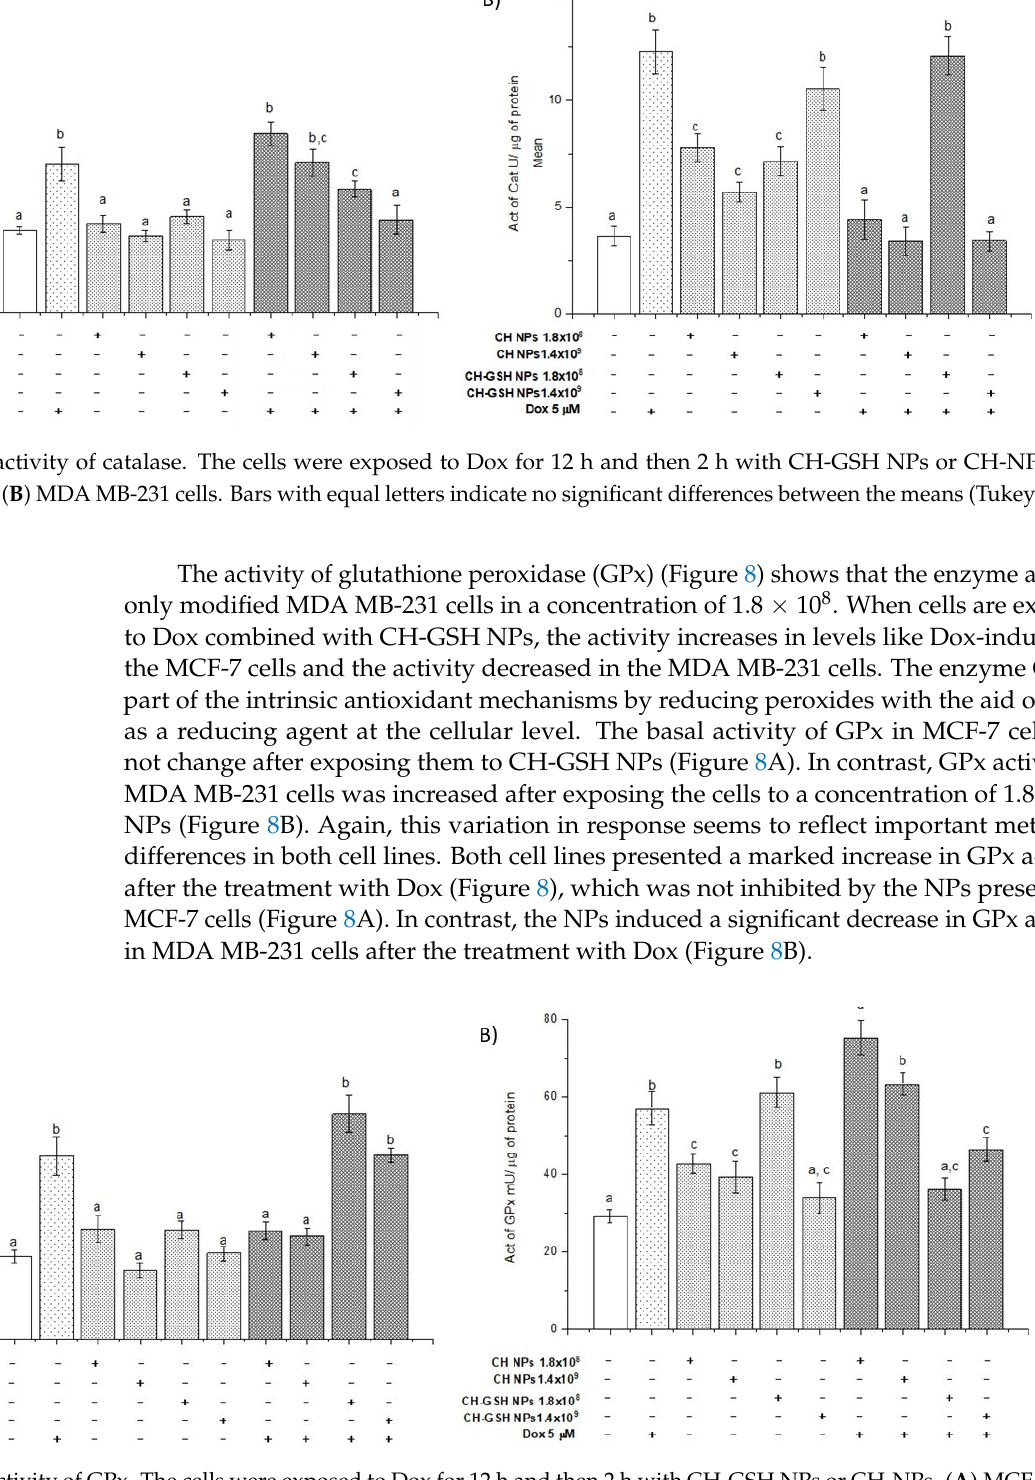
Figure 8. The activity of GPx. The cells were exposed to Dox for 12 h and then 2 h with CH-GSH NPs or CH-NPs. (A) MCF-7 and (B) MDA MB-231 cells. Bars with equal letters indicate significant differences between the means (Tukey’s test, p <0.05).